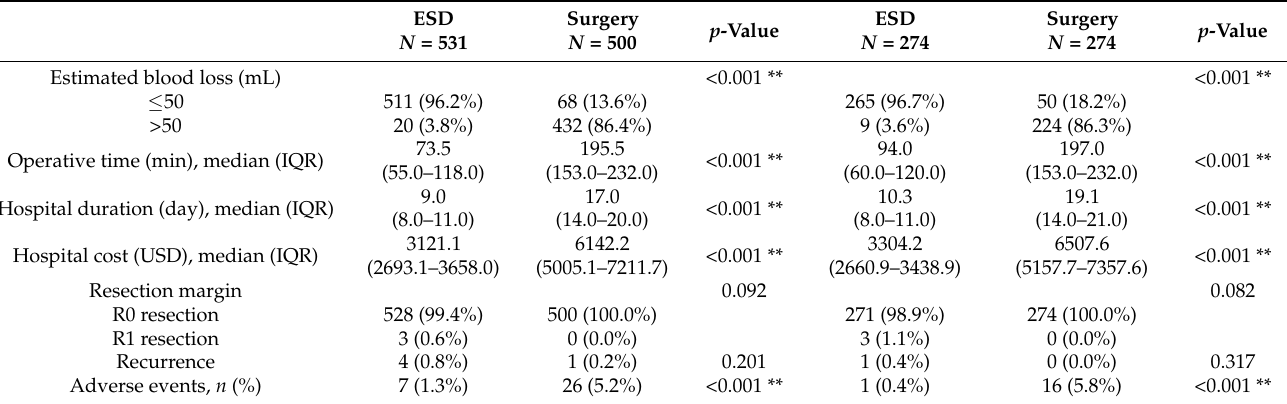
Table 2. Clinical outcomes of the two study populations.